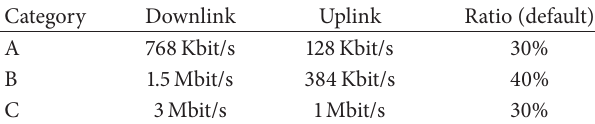
Table 3: Peer bandwidth distribution.